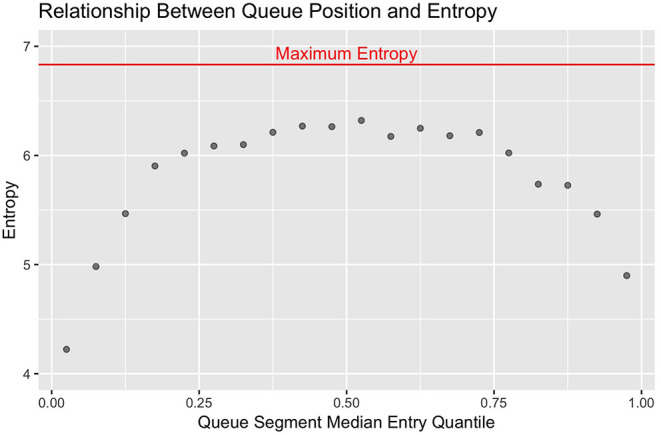
Entropy estimates from observed (red) and randomly permuted (blue) datasets are plotted against the median quantile value for the corresponding segment of the queue. The front and end of the queue are the least stochastic, but all sections of the queue demonstrate lower entropy than with purely random queue formation.